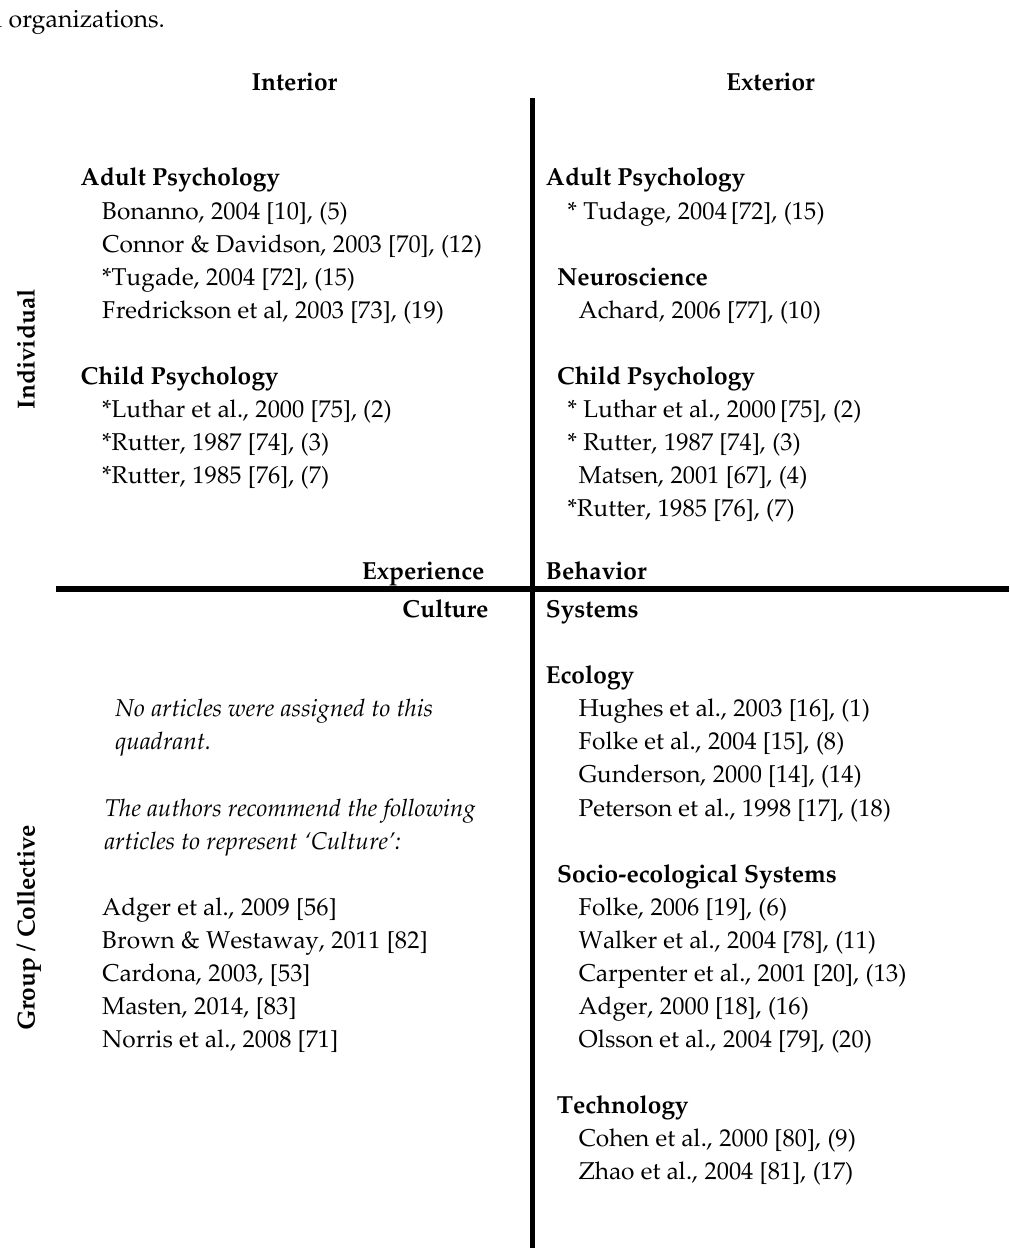
Figure 3. The top 20 most cited peer review journal articles aligned with the integral heuristic corresponding to each quadrant in Figures 1 and